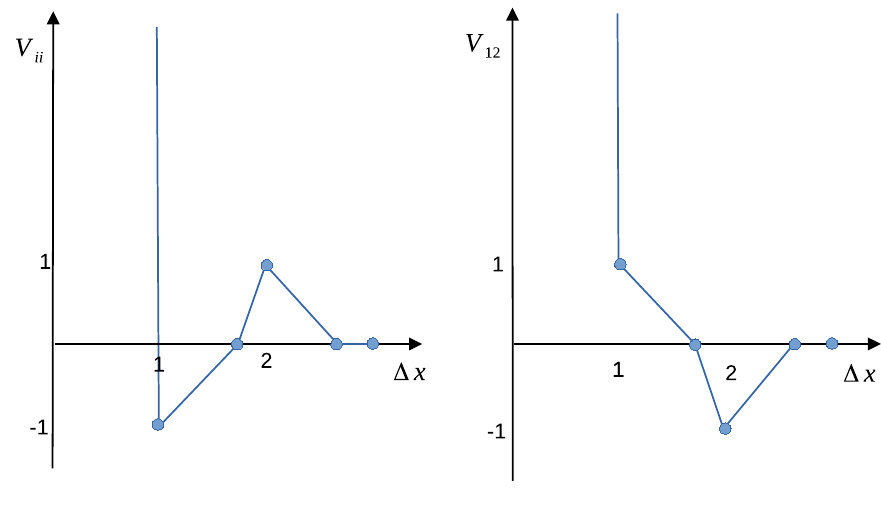
Figure 1. The interactions given in (1) and (2) in units of J 1 for J = J 2 / J 1 = 1. The ( left ) and ( right ) panels correspond to the interaction between like and different particles, respectively. The filled circles indicate the interactions between the particles occupying the lattice cells on the triangular lattice, and the lines are to guide the eye. The vertical lines at ∆ x = 1 represent the infinite repulsion for overlapping cores of the